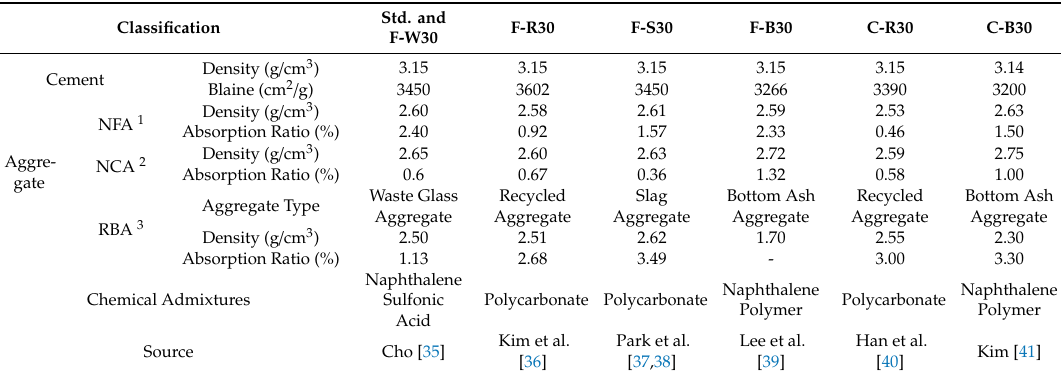
Table 3. Physical Properties of the Materials used in the Concrete Mixture